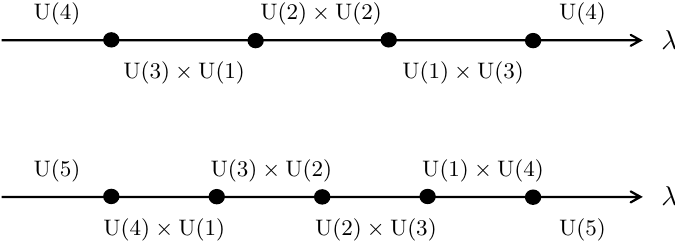
g 1 = 1 and g 2 = 3 as a function of e λ . e e